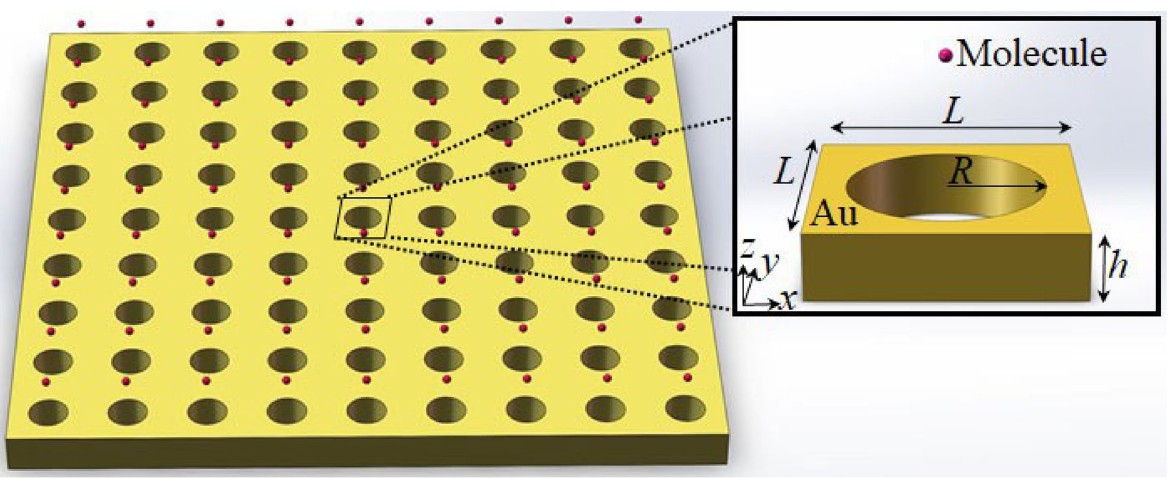
(cid:2) respectively, and g is the coupling constant. Strong cou- ω ± = ω − 0.25 i (γ + γ ) ± [ g 2 − 0.25 (γ c − γ m ) 2 ] c m 0 pling occurs for g > 0.5 | γ c − γ m | and corresponds to the (2) formation of a dressed state with a finite lifetime. For our proposed structure, the coupling constant g is 144 meV, while 0.5 | γ c − γ m | is 143 meV. In previous works, Rabi splitting denoted as (cid:6) = | ω + − ω − | is in the regime from where ω 0 is the energy under the condition that the iso- 100 to 450 meV in the structures based on the J aggregate- lated molecule and cavity are assumed to be in resonance, = 4.08 × 10 13 Hz [38] and γ = 1.1 × 10 14 Hz are γ metal or the molecule-metal hybrid nanostructures c m [39, 40]. The Rabi splitting is related to the coupling the decay rates of the plasmonic cavity and the molecule,